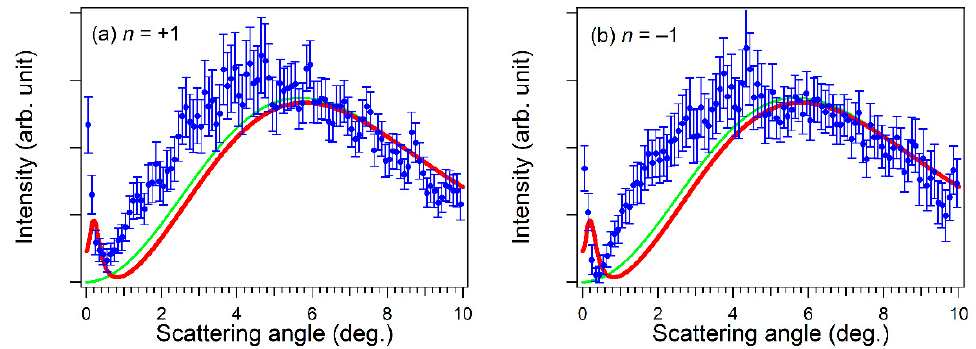
Figure 8. Angular distributions of the LAES signals of ( a ) n = +1 and ( b ) n = − 1 [10]. The blue filled circles are the experimental data, the green solid lines are the simulations based on the Kroll–Watson theory, and the red solid lines are the simulations based on Zon’s model. The experimental conditions are the same as those in Figure 6.